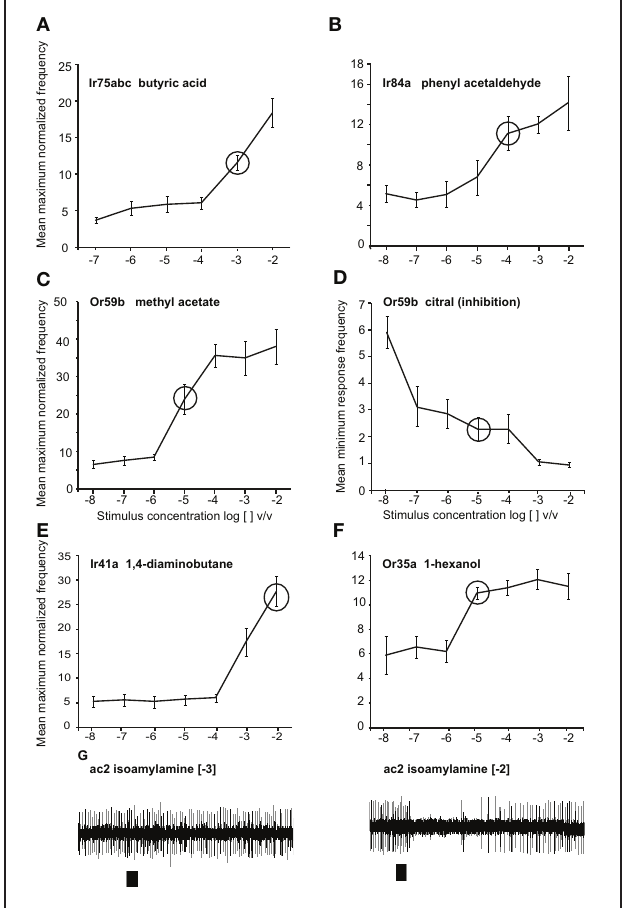
FIGURE 1 | Responses to odors at different doses. Dose-response curves presented as normalized maximum frequency response for (A) Ir75abc-expressing neurons to butyric acid n = 8–13 (B) Ir84a-expressing neurons to phenylacetaldehyde, n = 9–12. (C) , Or59b-expressing neurons to methyl acetate, n = 8–17 (D) Or59b-expressing neurons to citral presented as the minimum frequency, n = 6–10. (E) Ir41a-expressing neurons to 1, 4-diaminobutane n = 6–8 (F) . Or35a-expressing OSNs to 1-hexanol, n = 6–8. (G) Representative traces showing the response of OSNs of ac2 sensilla to isoamylamine at two different concentrations (responses to lower concentrations were not observed). Please note that while only Ir41a-expressing neurons are excited by 1, 4-diaminobutane in this sensillum (ac2), all neurons are inhibited by isoamylamine, and we thus label the inhibitory responses with the entire sensillum